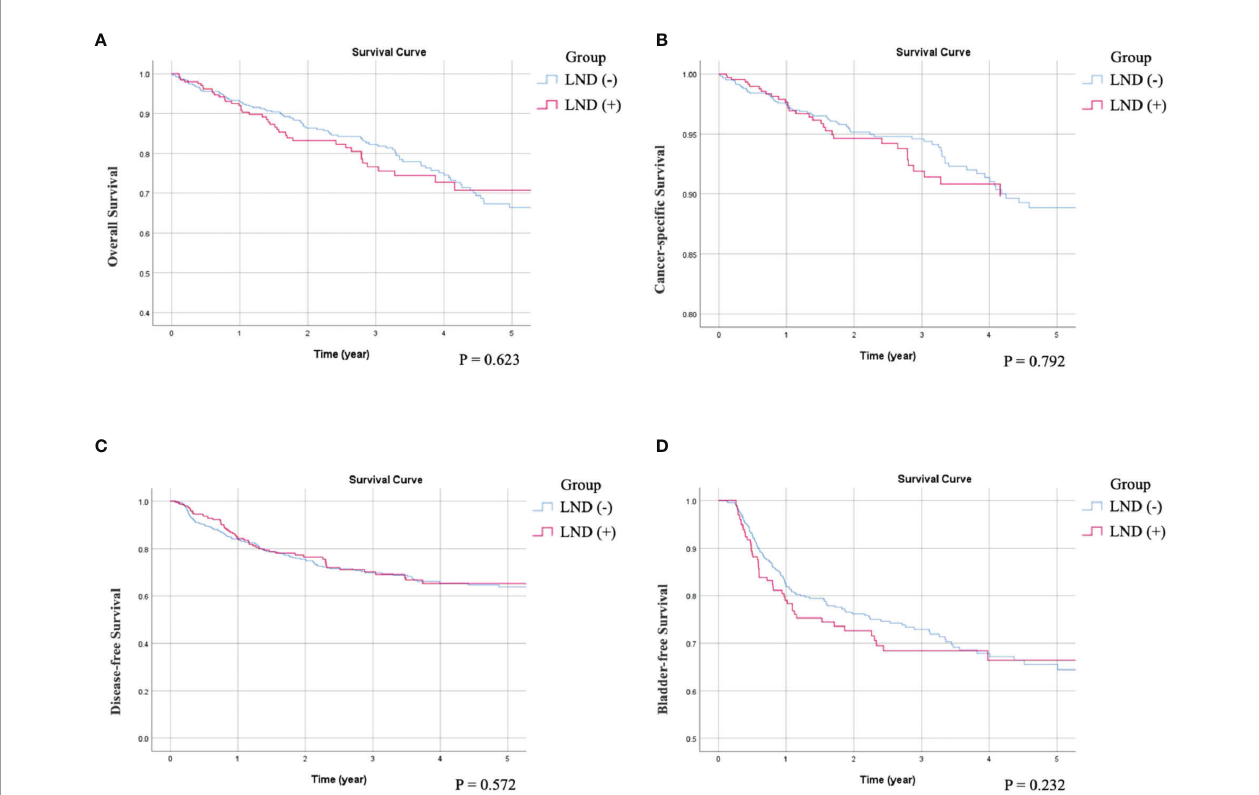
FIGURE 2 | Compare Kaplan-Meier curves between patients without receiving LND (LND (-)) or with receiving LND (LND (+)) after adjusting variables. (A) Overall survival, p = 0.623. (B) Cancer-speci fi c survival, p = 0.792. (C) Disease-free Survival, p = 0.572. (D) Bladder recurrence-free survival, p = 0.232.